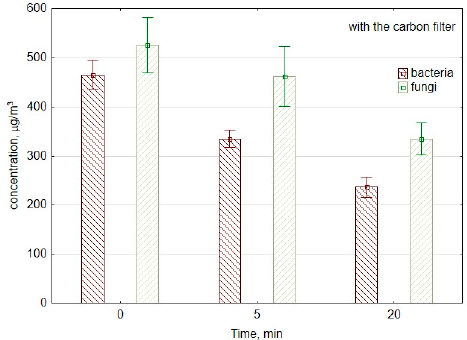
Figure 5. The average concentration of bacterial and fungal aerosols during the work of air purifier consisting of mesh filter, ozone generator, and carbon filter. The data represent the average values and the standard deviations of six measurements.